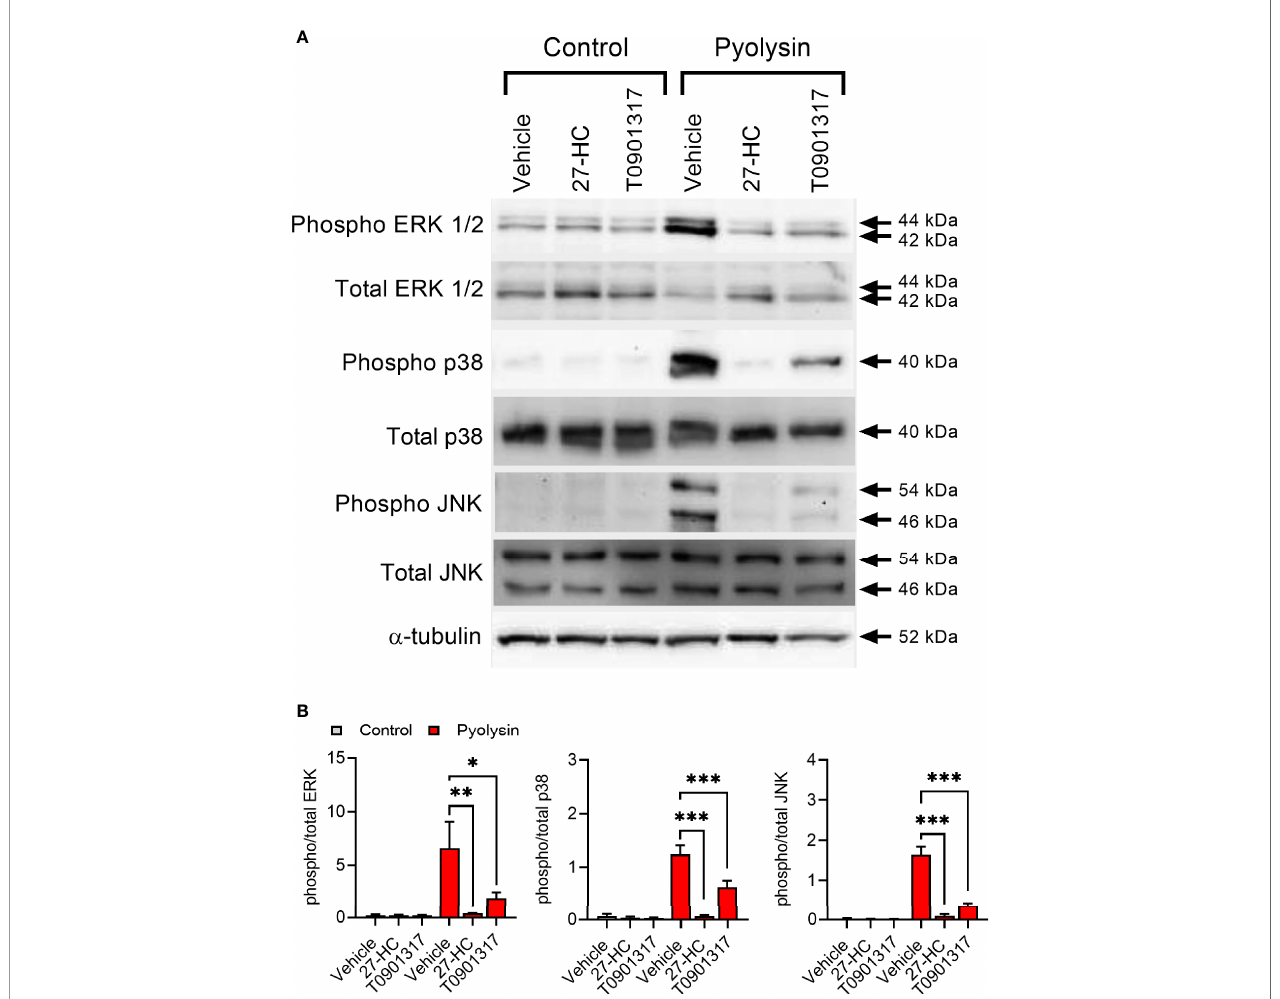
FIGURE 3 | 27-hydroxycholesterol prevents MAPK phosphorylation. (A) Representative Western blots of phosphorylated and total ERK1/2, p38 and JNK, and a - tubulin for HeLa cells treated with vehicle, 10 ng/ml 27-hydroxycholesterol (27-HC) or 50 nM T0901317 for 24 h, and challenged with control serum-free medium or 100 HU pyolysin for 10 min. (B) Densitometry data were normalized to a -tubulin, and presented as mean + s.e.m. from 3 independent experiments; statistical signi fi cance was determined using ANOVA with Dunnett ’ s post hoc test, ***P < 0.001, **P < 0.01, *P <